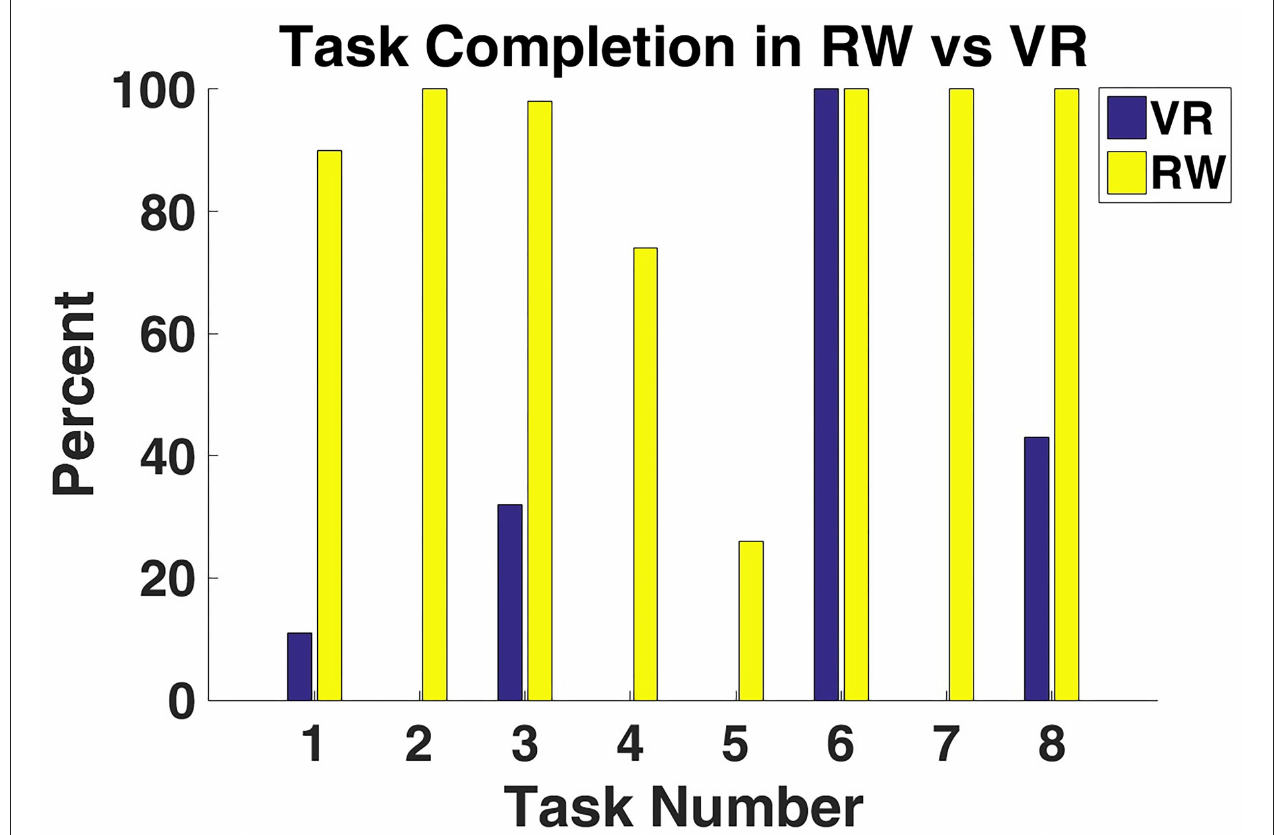
FIGURE 5 | VR and RW task completion percentage for all subjects. Subjects were only able to complete a subset of the tasks in VR, while they were able to complete all the tasks in RW.